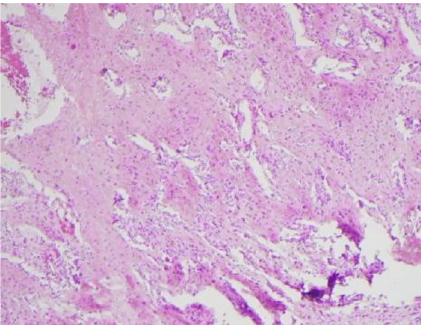
Figure 6: Osteoclast type giant cells in subperiosteal ABC clustering around hemorrhagic spaces (H&E,